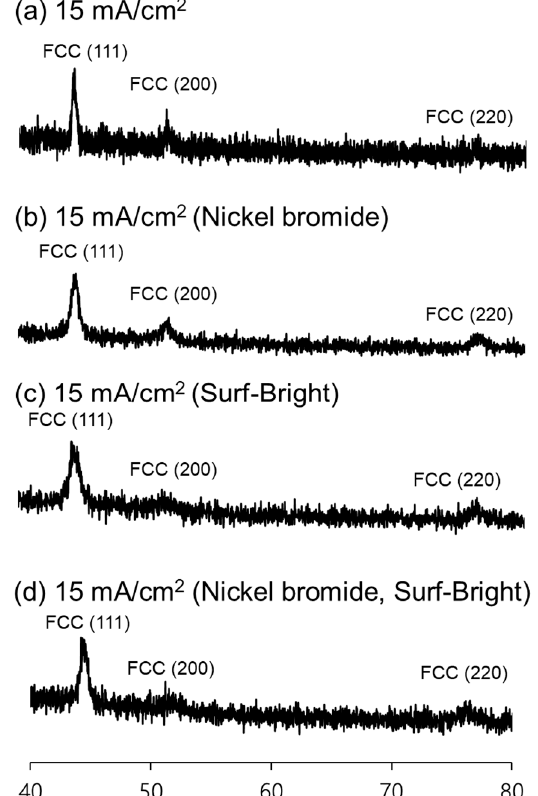
Figure 2. XRD patterns of the nickel–cobalt alloys electrodeposited with a current density at 15 mA/cm 2 and the bath containing ( a ) no additives, ( b ) nickel bromide, ( c ) the Surf-Bright and ( d ) both nickel bromide and the Surf-Bright.